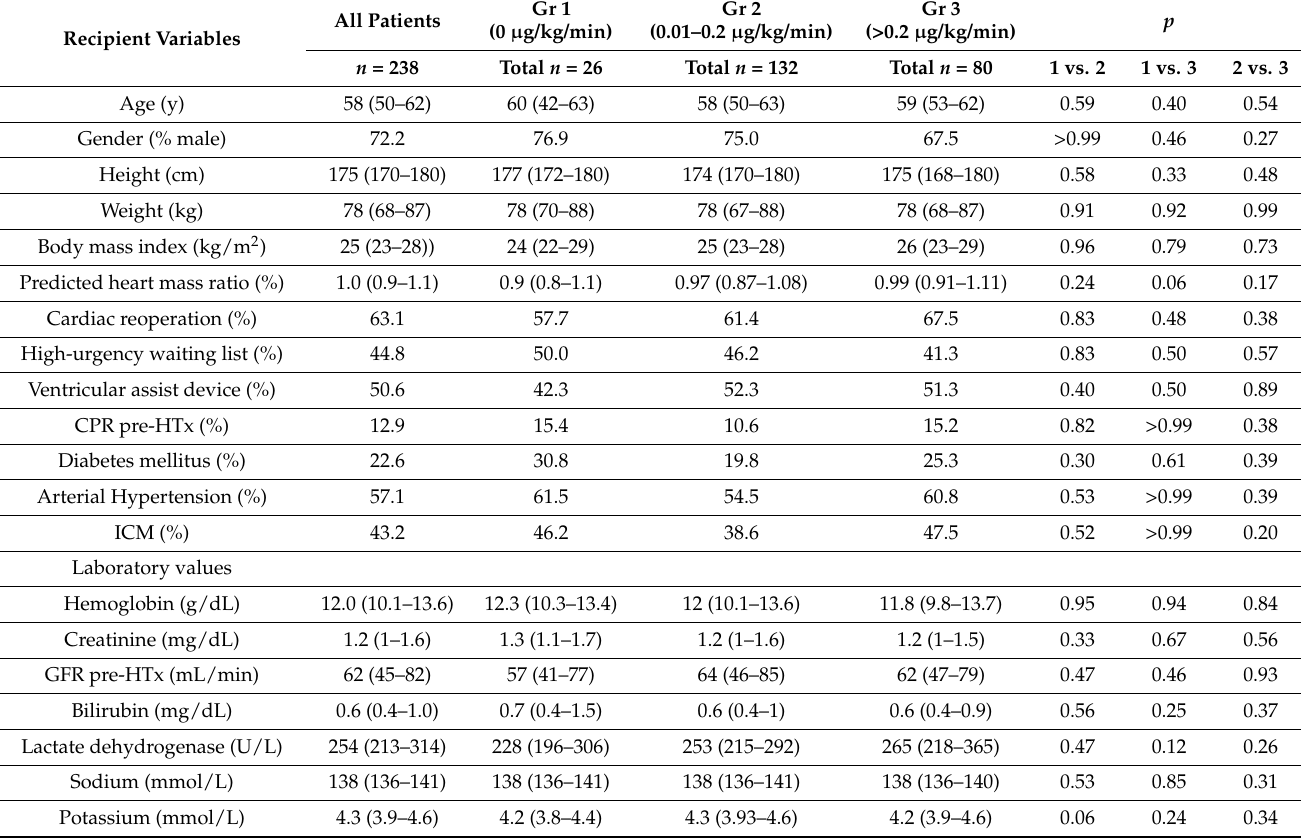
Table 1. Preoperative recipient parameters. Preoperative recipient data regarding the donor no- radrenaline support: No (0 µ g/kg/min, n = 26), medium (0.01–0.2 µ g/kg/min, n = 132) or high (>0.2 µ g/kg/min, n = 80). Shown are median values with interquartile range (Q1–Q3) for continu- ous variables or percentages for discrete variables. Significance was calculated using the Pearson chi-square test or, if its conditions of application were not met, the Fisher’s exact test for qualitative variables and the t -test for quantitative